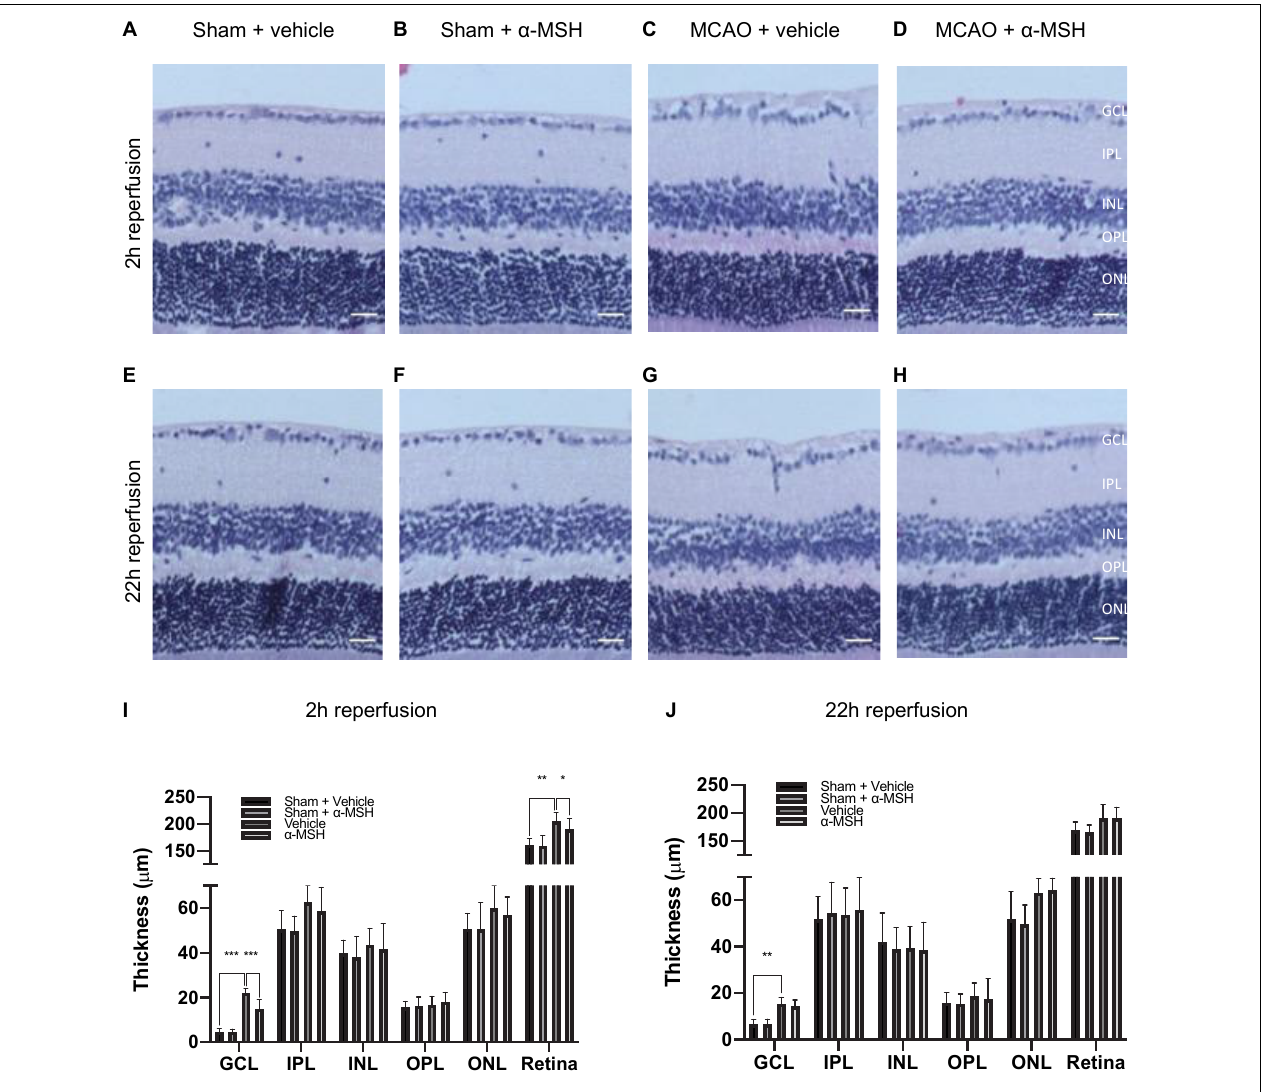
FIGURE 2 | α -MSH preserved morphological integrity of retina after I/R injury. (A–D,I) Thicknesses of GCL and total retina were significantly higher in animals treated with vehicle compared with α -MSH-treated animals or vehicle-treated sham animals at 2 h of reperfusion. (E–H,J) Only thickness of GCL was significantly higher in vehicle-treated animals compared to vehicle-treated sham animals at 22 h of reperfusion. * P < 0.05, ** P < 0.01, *** P < 0.001, One-way ANOVA followed by Tukey’s test, n = 6 for each group. Scale bar = 25 µ